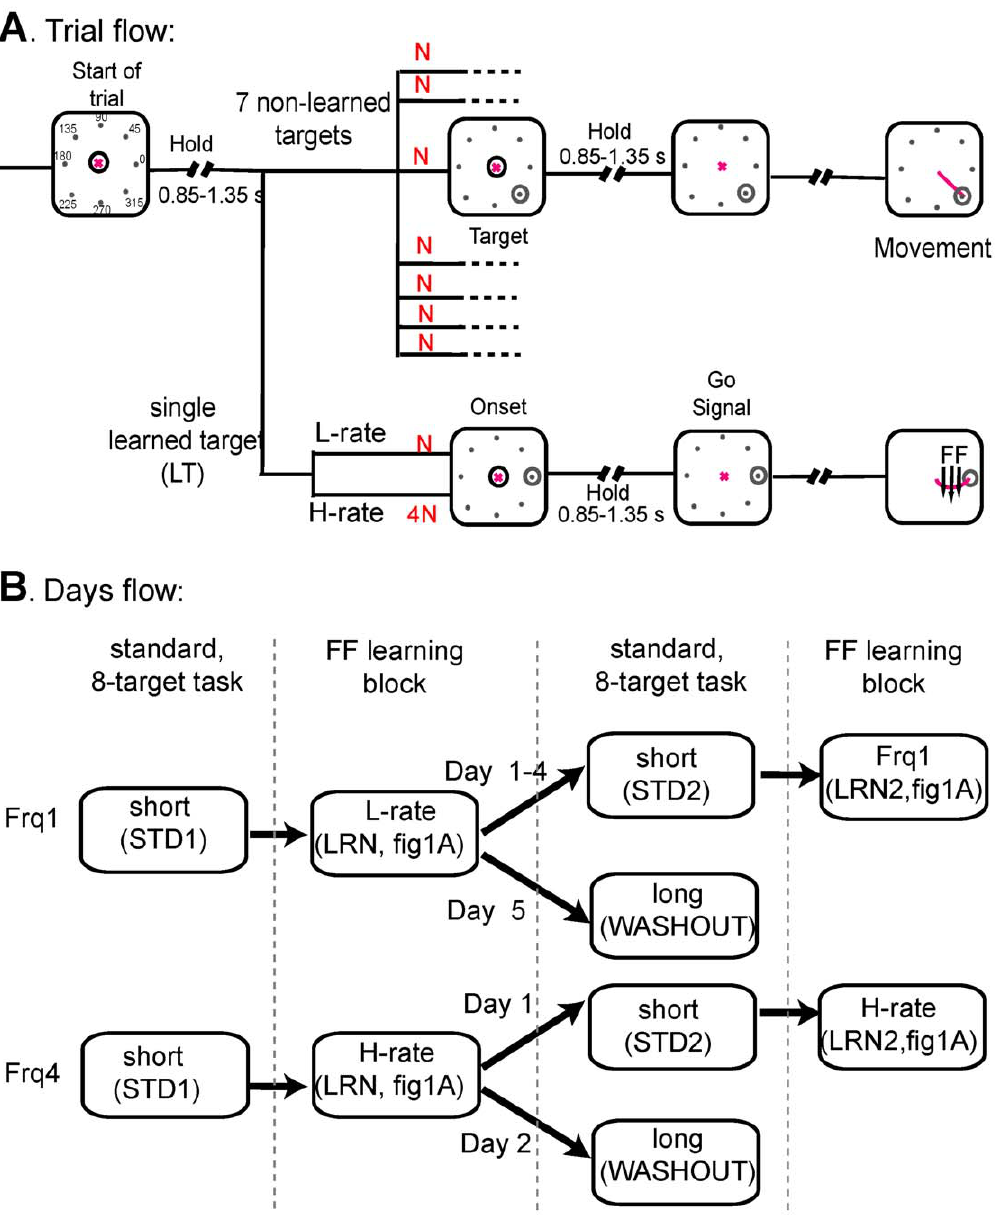
Figure 1. Experimental design. (A) example of a trial flow (left to right) during a learning epoch under ‘‘L-rate’’ and ‘‘H-rate’’ practice schedules. During the first delay period the monkey held the robotic arm in the center without moving it. The monkey kept holding at the central circle after target onset for an additional delay and moved after the go signal. In the figure the learned target is at 0 u and the force field (FF) is clockwise (parallel arrows). If the lit target was the selected learned target (lower row), then the force-field was applied when movement was initiated, otherwise (upper row) movement was executed under standard conditions. Under the L-rate schedule the learned target appeared as often as the other targets (N), and under the H-rate schedule, four times more frequently (4*N). (B) Recording day flow: all days started with standard trials (center-out reaching movements to eight directions) followed by a learning epoch. From the first day until the day before last (fourth day under the L-rate, first day under the H-rate) the learning epoch was followed by a second standard epoch and then ended with a second learning epoch. The last day of the learning set (fifth day under the L-rate, second day under the H-rate) consisted of only three epochs in which learning was followed by a long standard epoch